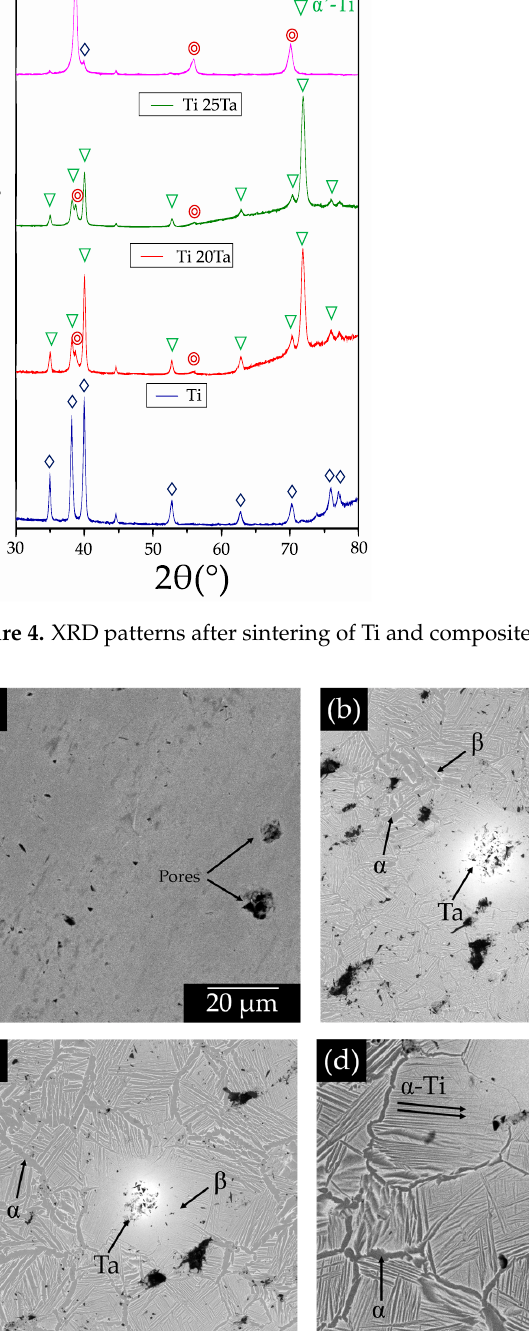
Figure 6. SEM micrographs of the different Ti-30Ta samples with large pores; ( a , b ) with 30 and 40 vol.% of pore formers added, respectively; and higher magnifications ( c , d ), respectively.